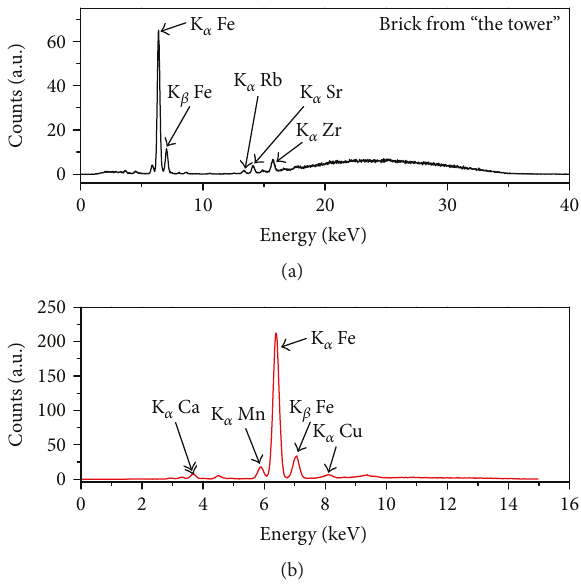
Figure 7: XRF spectra, in the 0 – 40 keV range (a) and 0 – 16keV range (b), of a brick from “ the tower. ”